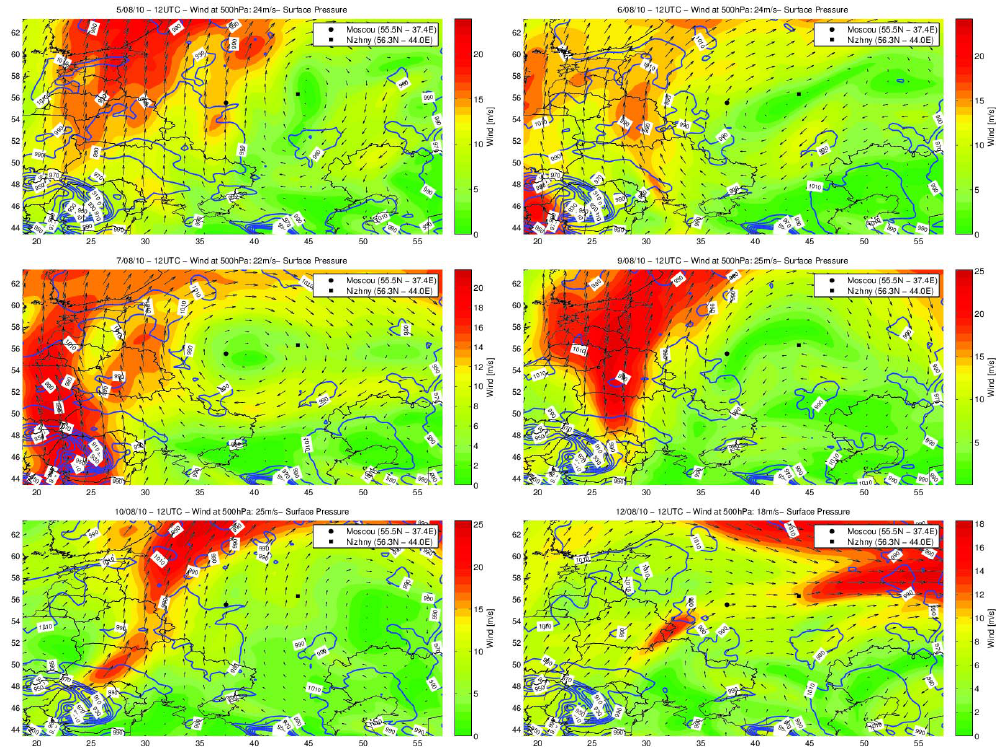
Fig. 1a. Surface pressure (blue lines) and 500hPa wind (black arrows and colour scale) at midday, simulated by WRF (without the ADRF feedback) during the studied period. The observatory stations of Moscow and Nizhny Novgorod are indicated.